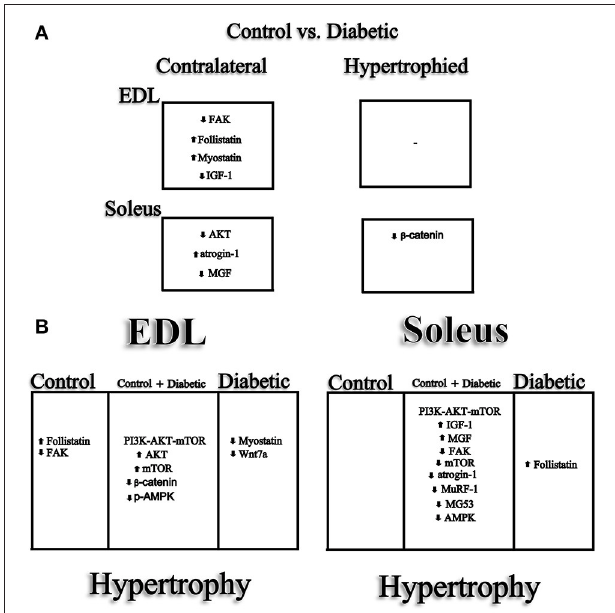
FIGURE 8 | Main signaling pathways involved in the hypertrophy of the soleus and EDL muscles. (A) Effect of the early diabetic condition upon mRNA content and (B) modulation of the main signaling pathways involved in the hypertrophy of the soleus and EDL muscles in control or diabetic animals and in